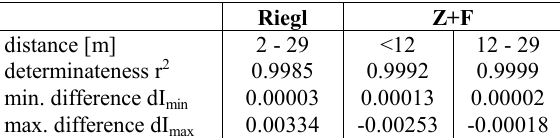
Table 3. Properties of fitted polynomials (Riegl and Z+F)